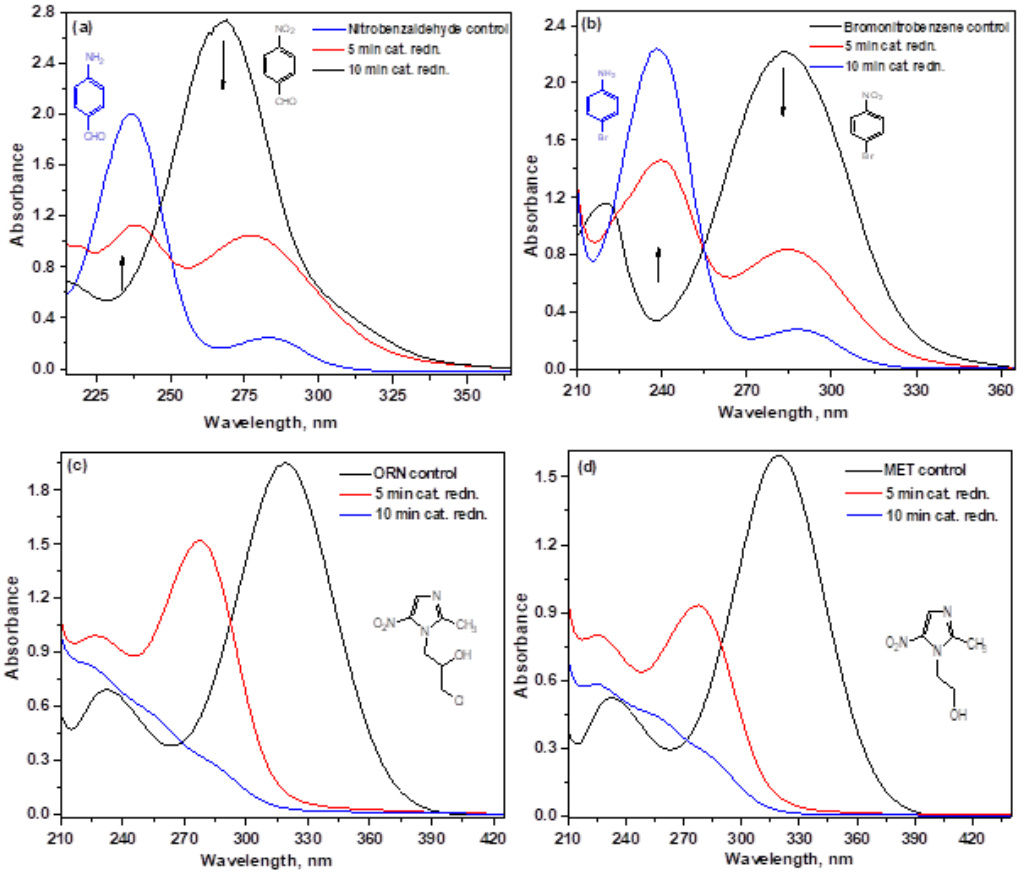
Figure 8. UV-vis absorption spectra of the reduction of various nitro compounds: ( a ) nitrobenzaldehyde, ( b ) 4-bromo nitrobenzene, ( c ) ornidazole and ( d ) metrnidazole over a PSE-capped Cu 2 O/CuO catalyst.